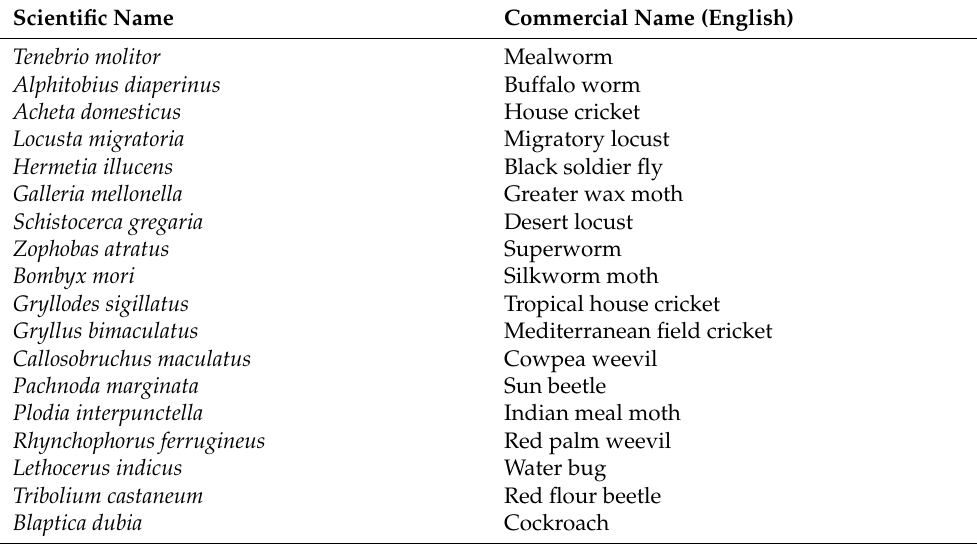
Table 1. Insect species used to develop the DNA metabarcoding